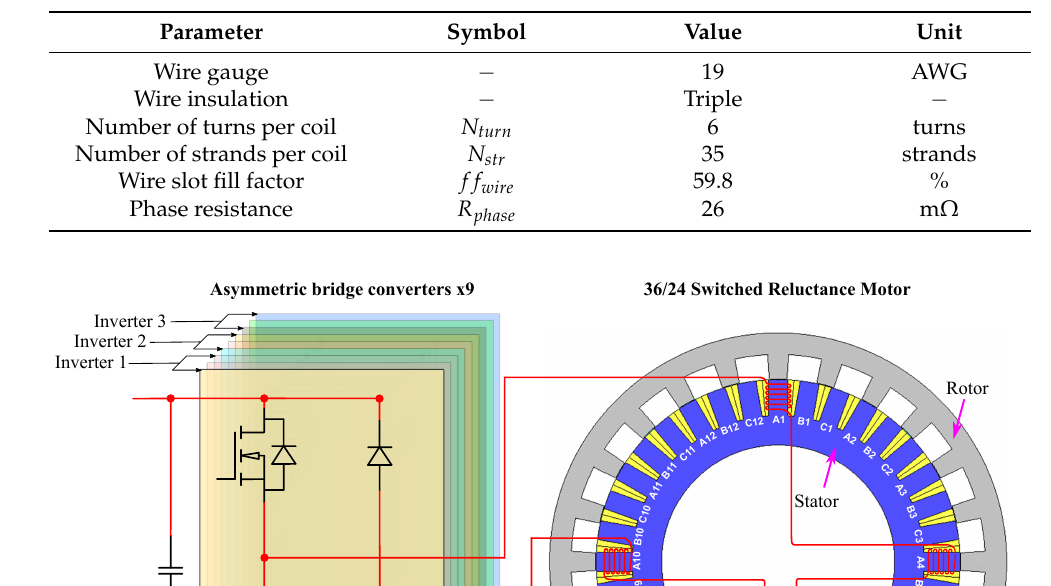
Table 9. Winding design parameters of 36/24 ERCV SRM.